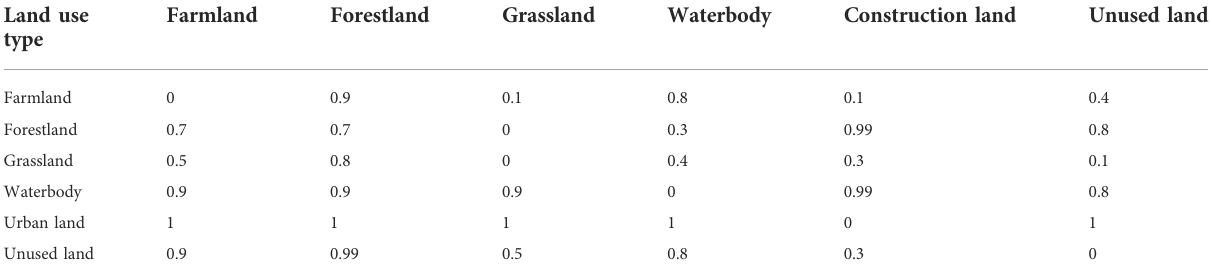
TABLE 3 Conversion cost of land use